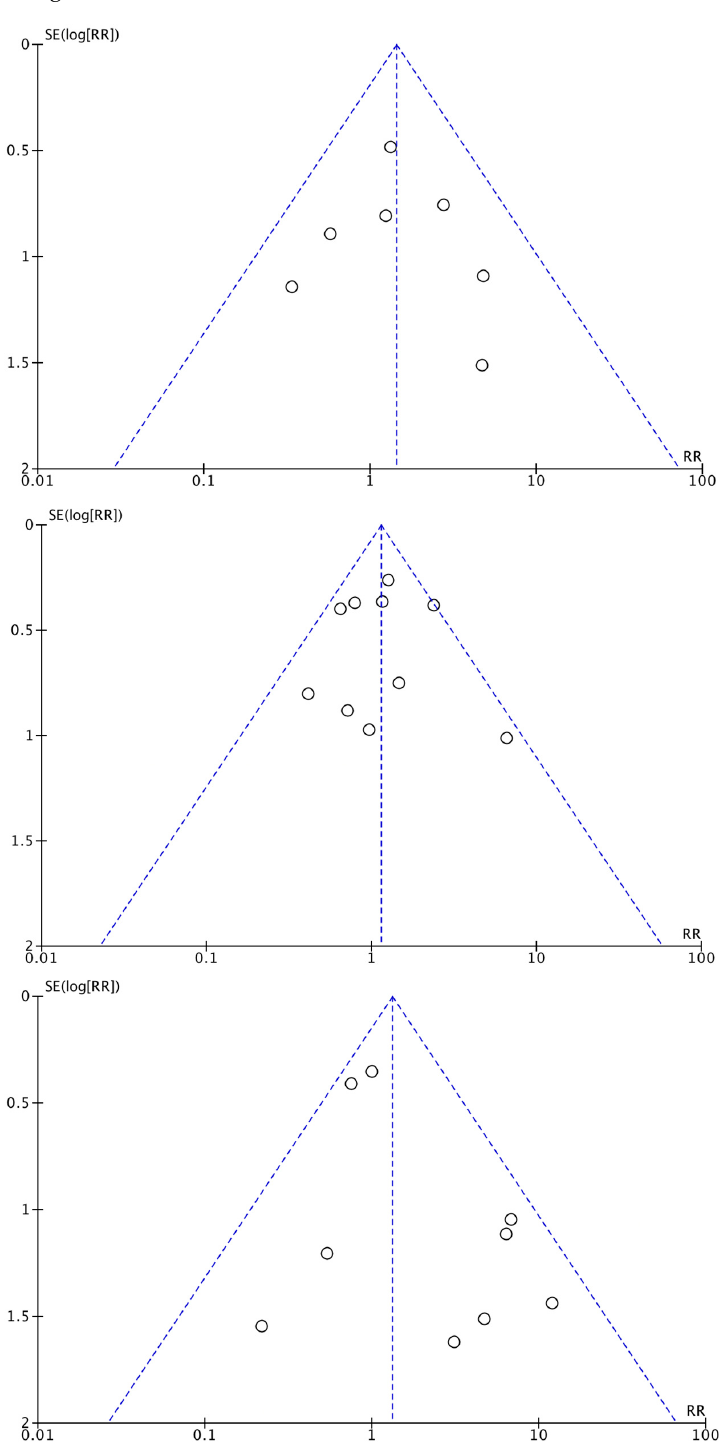
Figure 2. Funnel plot: mortality ( above ), clinical failure ( middle ), and bacteremia ( below ).